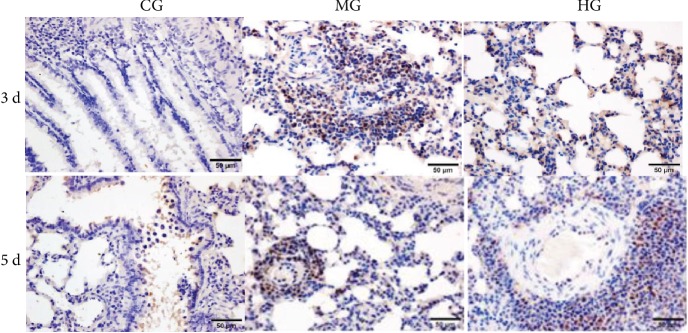
Tunnel analysis of the effects of hydrostatin-SN10 on the apoptosis of lung tissues among different groups.